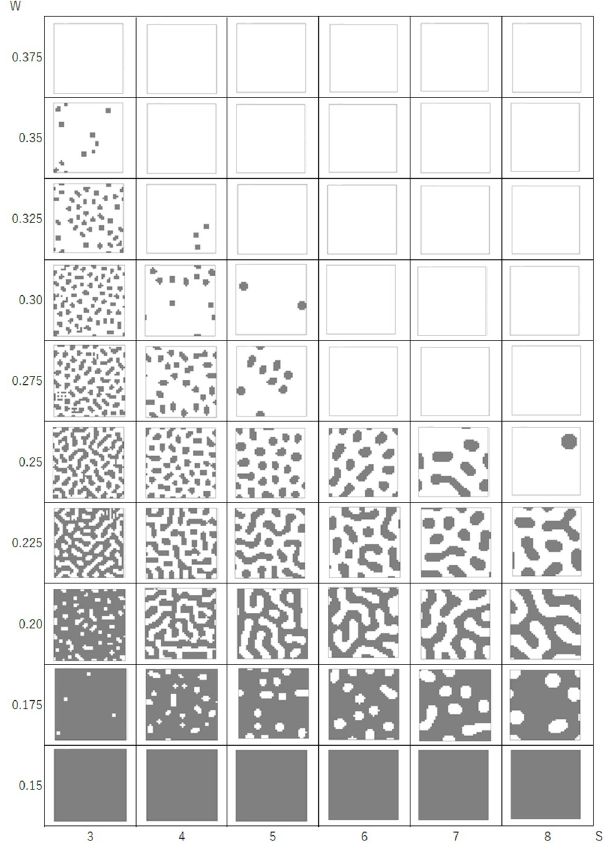
Fig 7. Results for the model using expression (1) in a square grid. S values are represented on the horizontal axis, and w values are represented on the vertical axis.